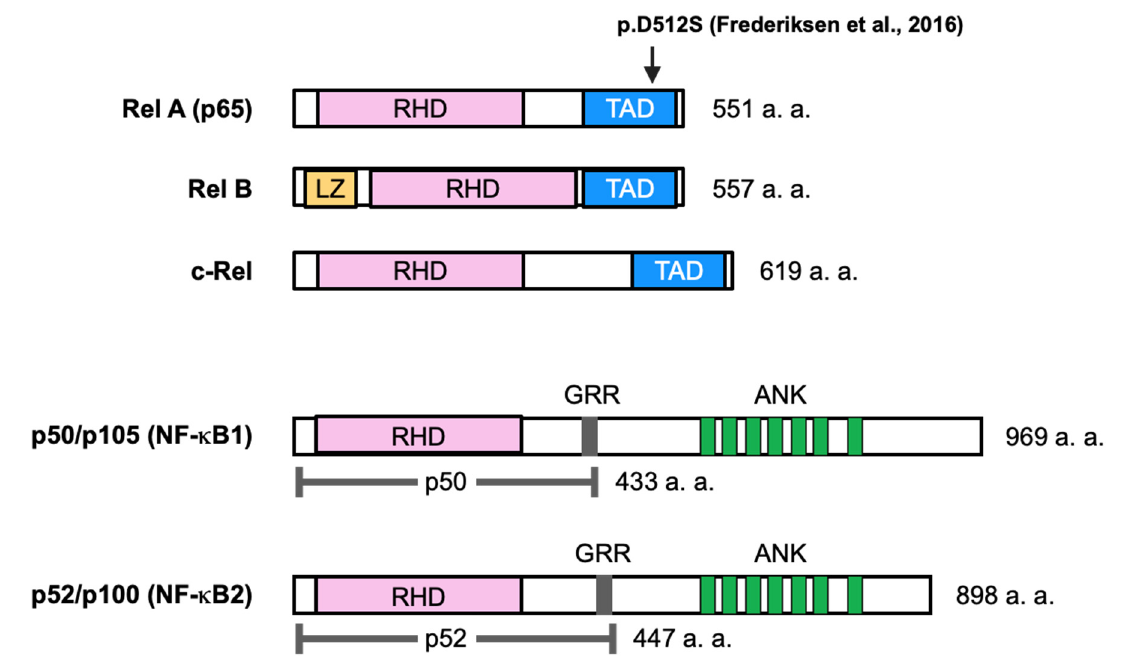
Figure 1. Schematic representation of the NF- κ B family proteins. Members of the NF- κ B protein family are shown. The total number of amino acids in each protein is indicated on the right. Presumed sites of cleavage in p105 (amino acid 433) and p100 (amino acid 447) are indicated by dotted lines. RHD: Rel homology domain; TAD: transcriptional activation domain [8]; LZ: leucine zipper; GRR: glycine-rich repeat; ANK: ankyrin repeat. An arrow indicates the position of a genetic mutation associated with osteopetrosis.